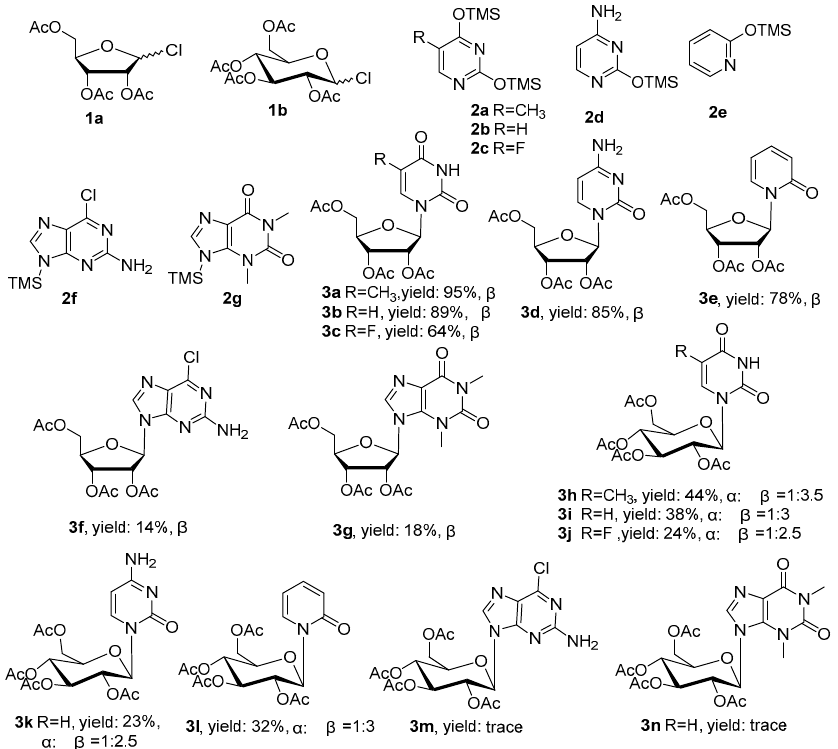
Figure 3. Nucleoside synthesis employing acetyl-glycosyl chlorides as glycosyl donors.